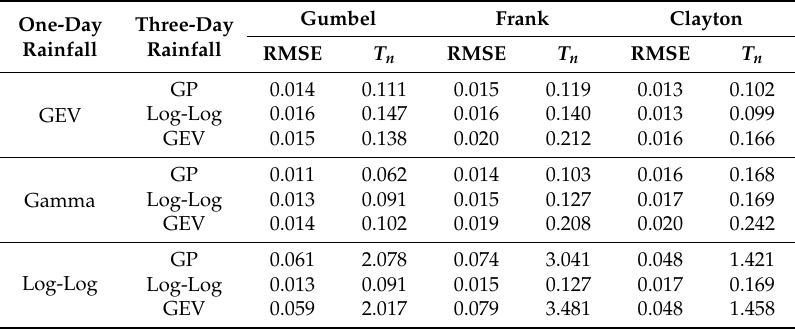
Table 6. Goodness-of-fit of the copulas for different combinations of marginal distributions of one-day and three-day rainfall.